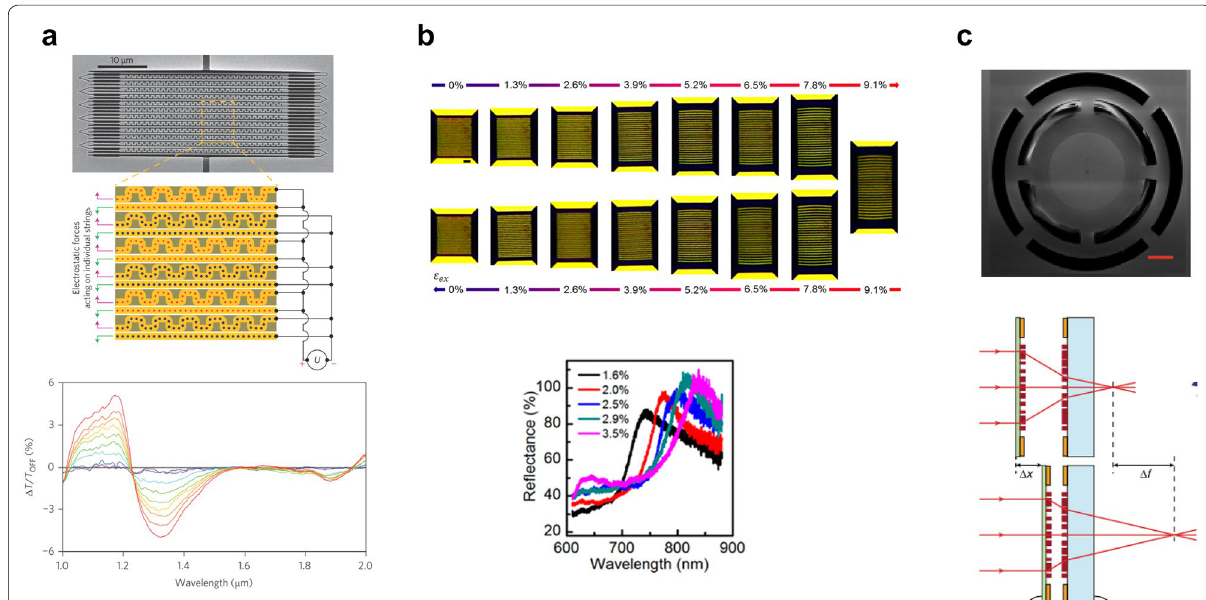
Fig. 3 Electromechanically tunable metasurfaces. a Tunable microbeam array actuated by electrostatic force [28]. Reproduced with permission from ©2013, Springer Nature. b Strain‑induced tunable grating on a PDMS substrate [68]. Reproduced with permission from ©2018, American Chemical Society. c Micro‑electro‑mechanical‑system‑based metalens doublet [30]. Reproduced with permission from ©2018, Springer